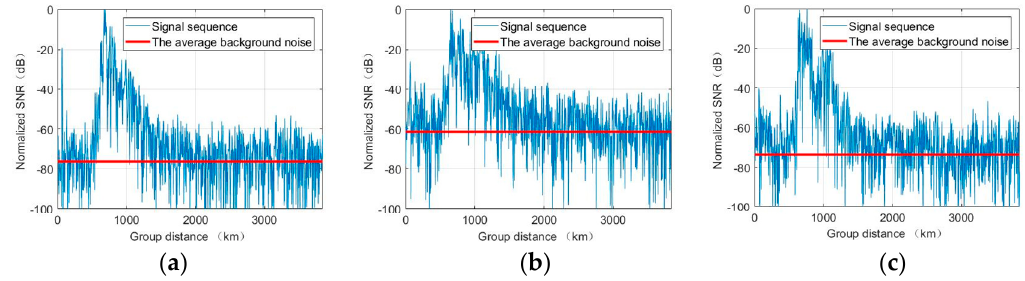
Figure 17. Normalized SNR of 7 MHz; ( a ) Channel 1; ( b ) SMI; ( c ) ESB.